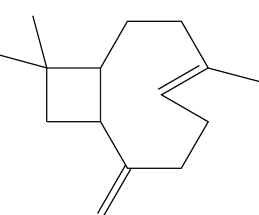
Figure 5: Structure of β -caryophyllene.